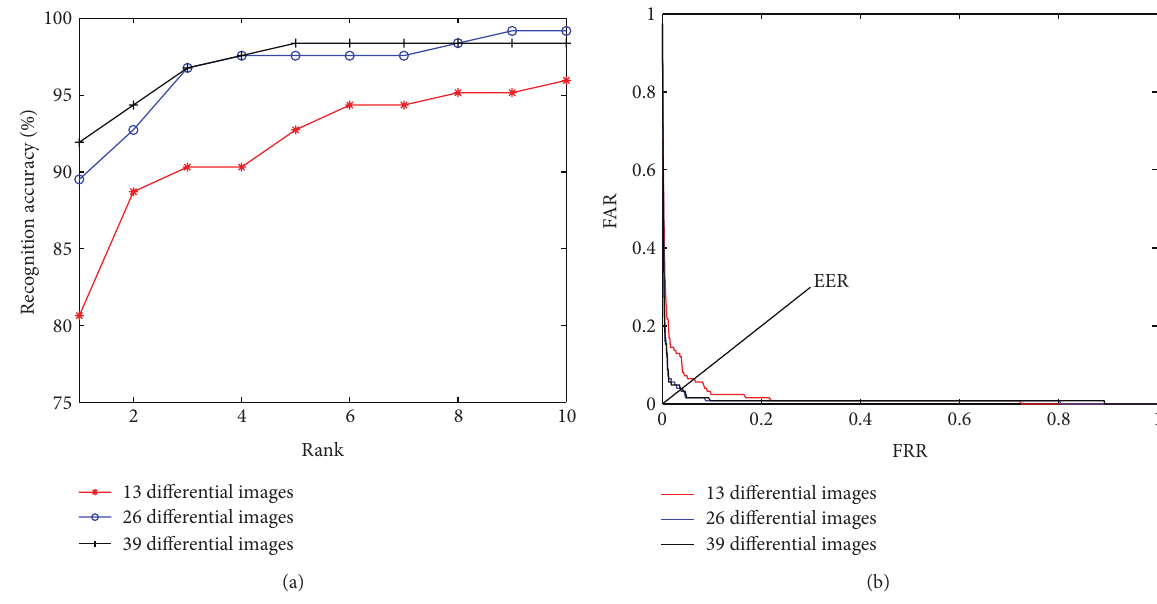
Figure 6: (a) Recognition accuracy of different probe sizes. (b) The comparison of ROC curves of different probe sizes.